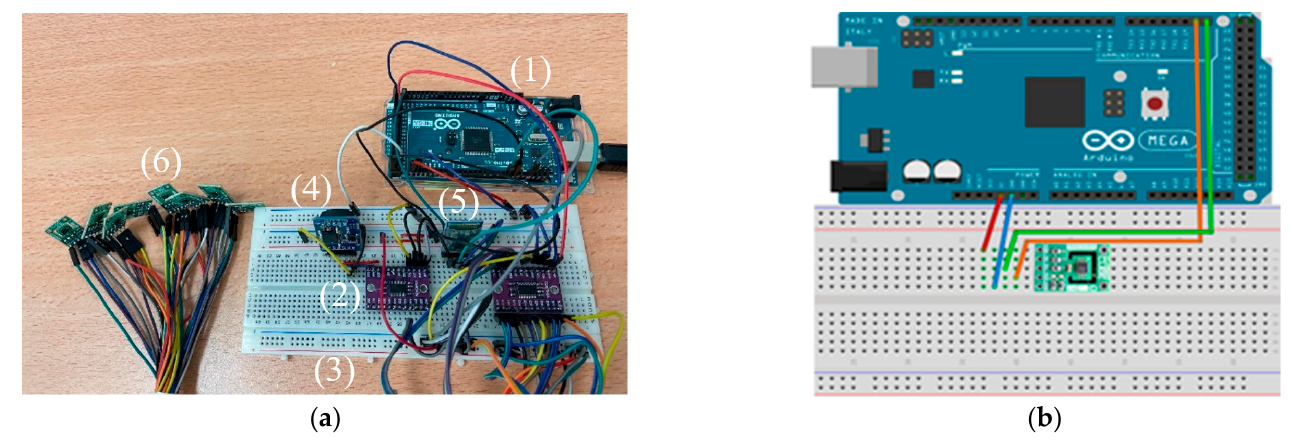
Figure 5. HEAT MAX30205: ( a ) Indoor module and wire connections of one MAX30205 sensor with the Arduino Mega ( b ).